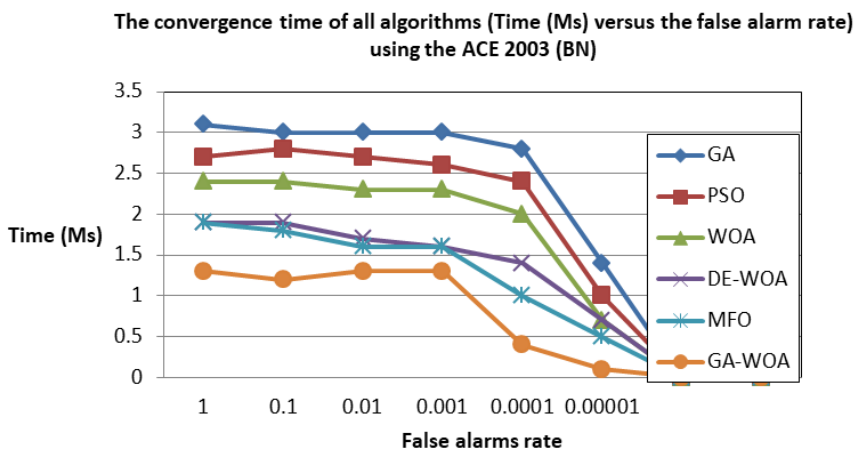
Figure 2. The convergence time versus the FAR rate for all algorithms using the ACE 2003 (BN) corpus.